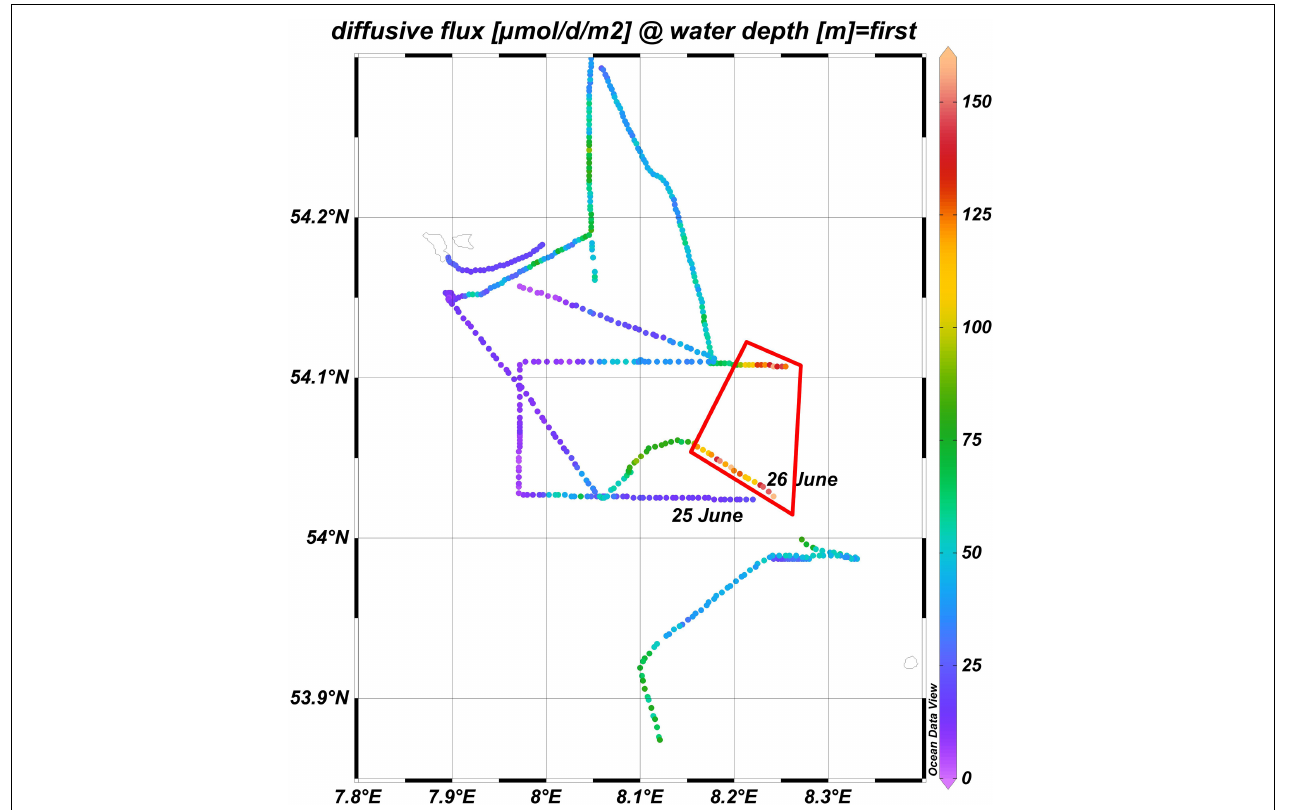
FIGURE 8 | Close up for the diffusive methane flux only in the marine area ( S > 30), red polygon indicated the area of increased flux.